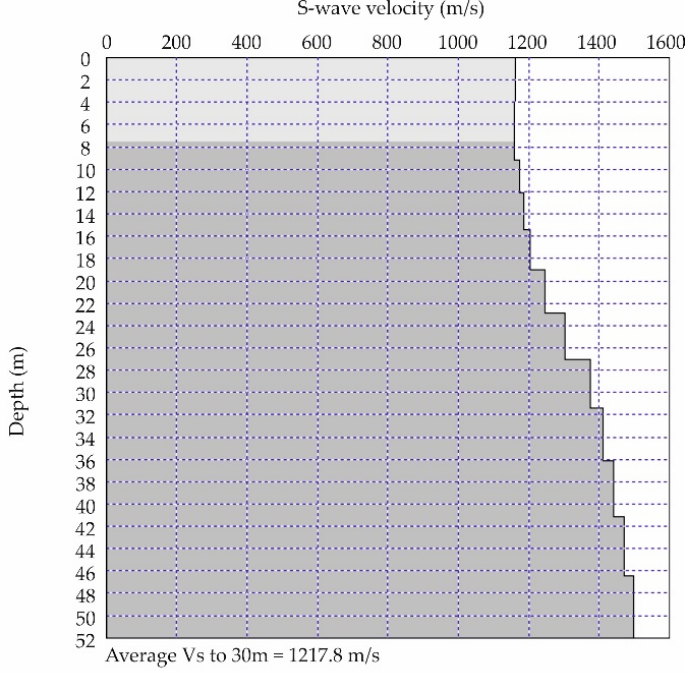
Figure A3. 1D Vs model derived from the MASW technique at VILL station.